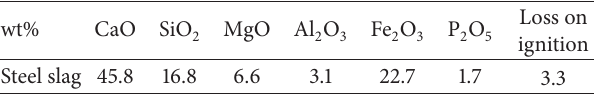
Table 2: Chemical components of